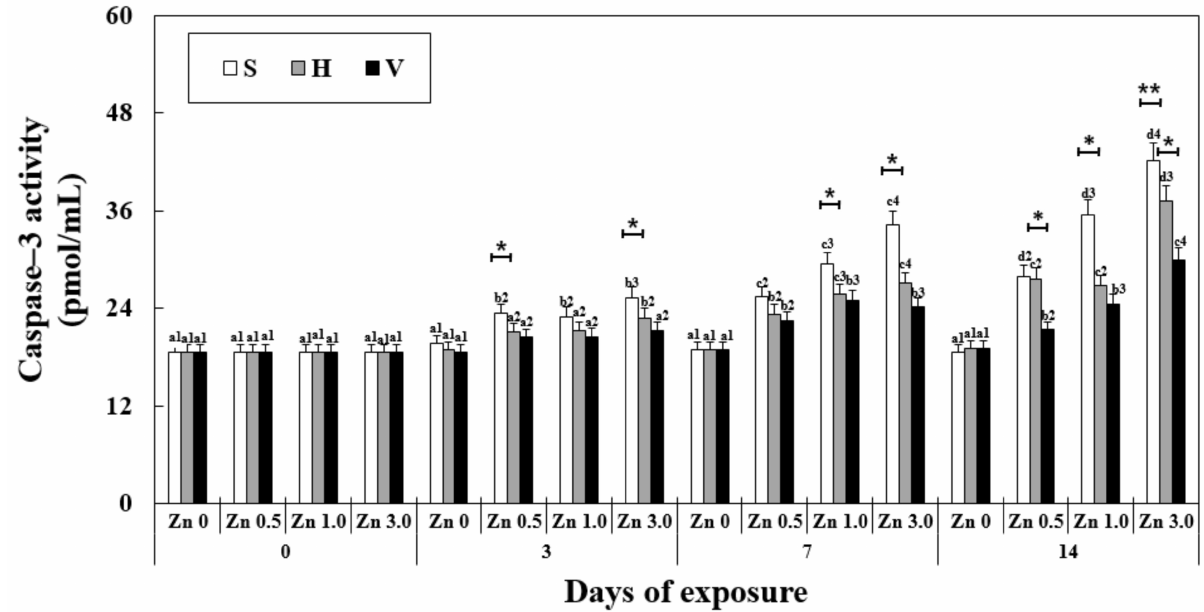
Figure 5. Changes in the activity of caspase-3 measured for 14 days. Different letters indicate significant differences among goldfish exposed to the same Zn concentration and water hardness for different exposure times ( p < 0.05). Different numbers indicate significant differences among goldfish exposed to different Zn concentrations at the same water hardness level and for the same duration. The symbol “*” and “**” represent statistical significance ( p < 0.05 and p < 0.01, respectively) among goldfish exposed to different water hardness levels at the same Zn concentration and for the same duration. Values are mean ± SD ( n = 4).